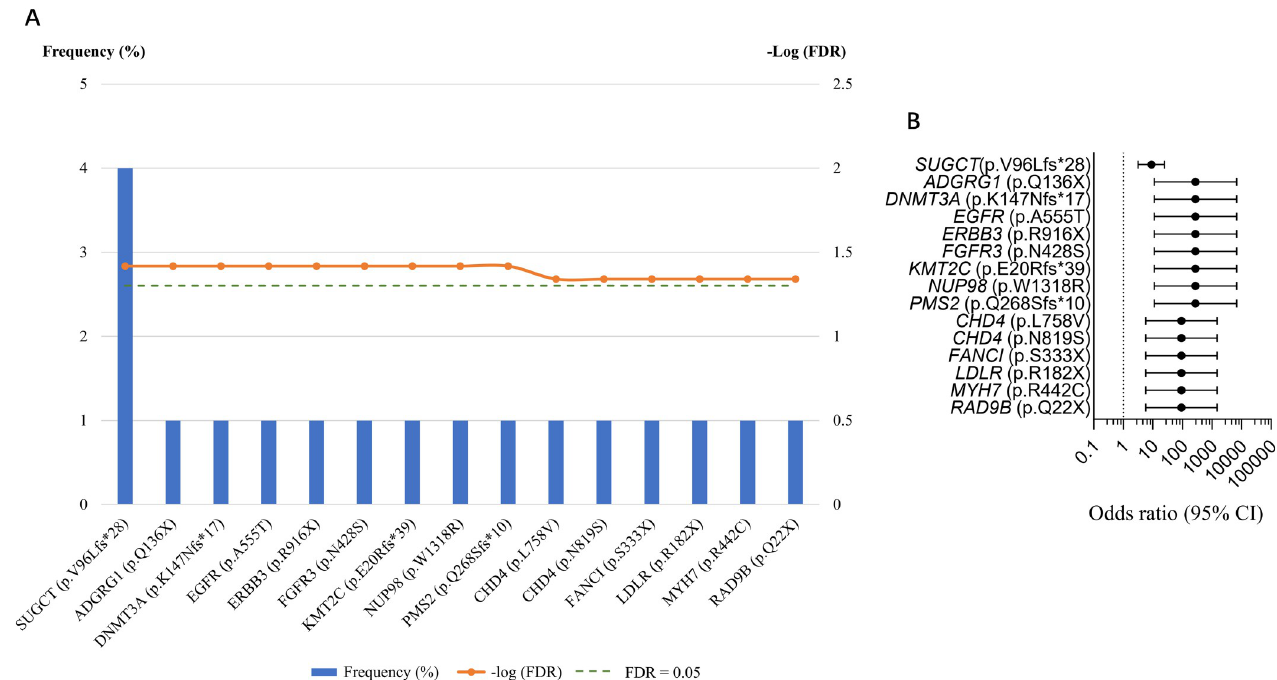
Fig 5. Deleterious germline mutations detected in the Hong Kong cohort compared with East Asian controls. (A) Deleterious germline mutations significantly enriched (False Discovery Rate � 0.05) in the Hong Kong cohort compared with 9,197 East Asian individuals from the GnomAD v2.1.1. (B) Odds ratio of deleterious germline mutations significantly enriched in the Hong Kong cohort compared with 9,197 East Asian individuals from the GnomAD